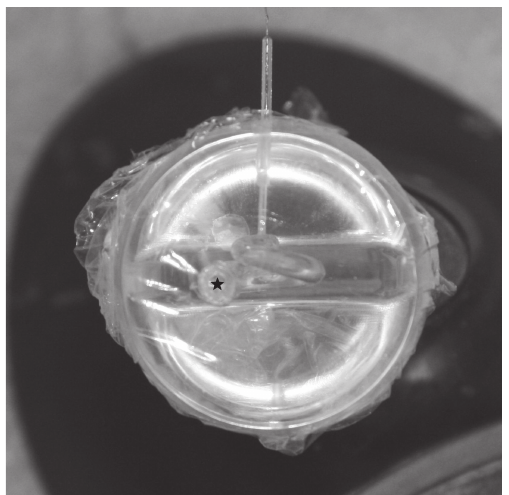
Figure 1: Artificial cochlea model with polythene foil. The sensor is placed in the helicotrema area. Figure 2: Top view on the cochlea model; the 󳀅 marks the round